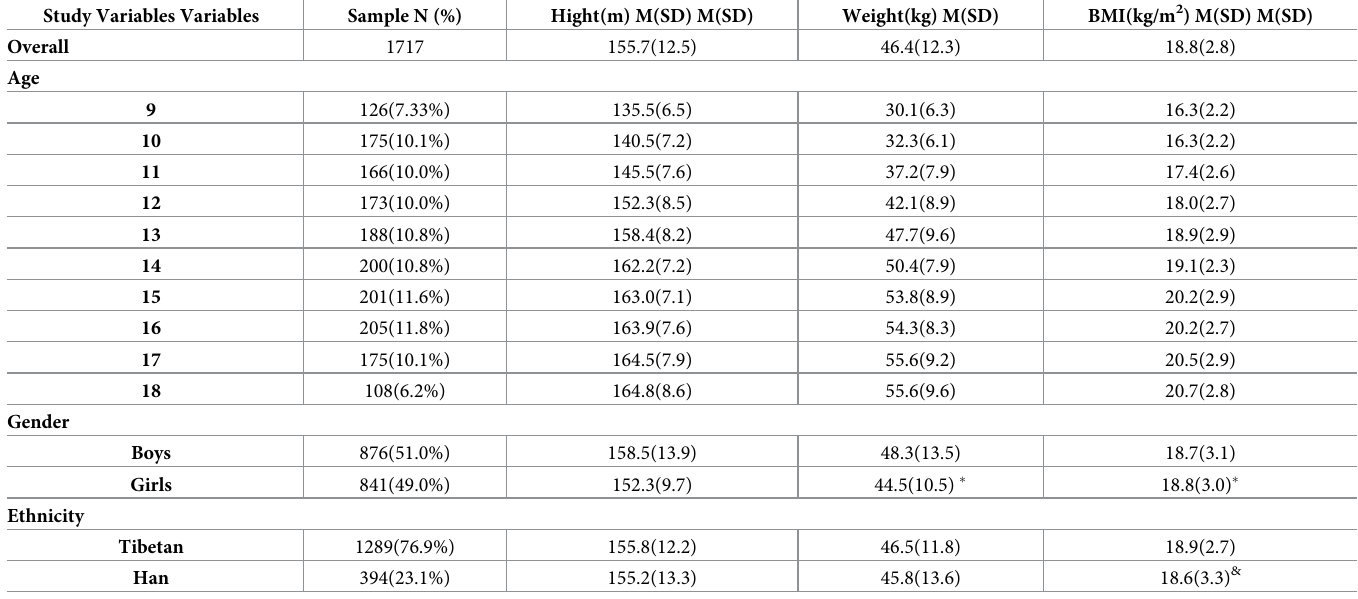
Table 1. Description of the study sample.